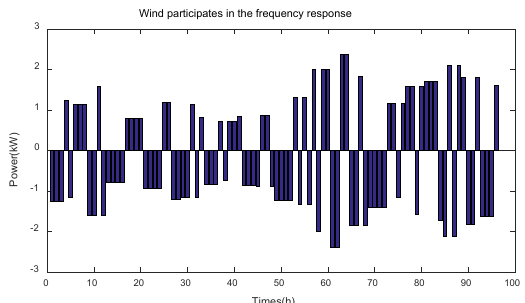
Figure 11. The output of WG participation in frequency regulation.